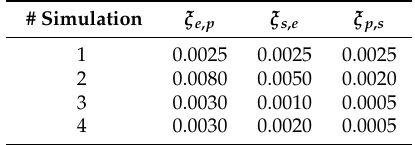
Table A6. Values of numerical parameter ξ in Simulation 1 to 4.